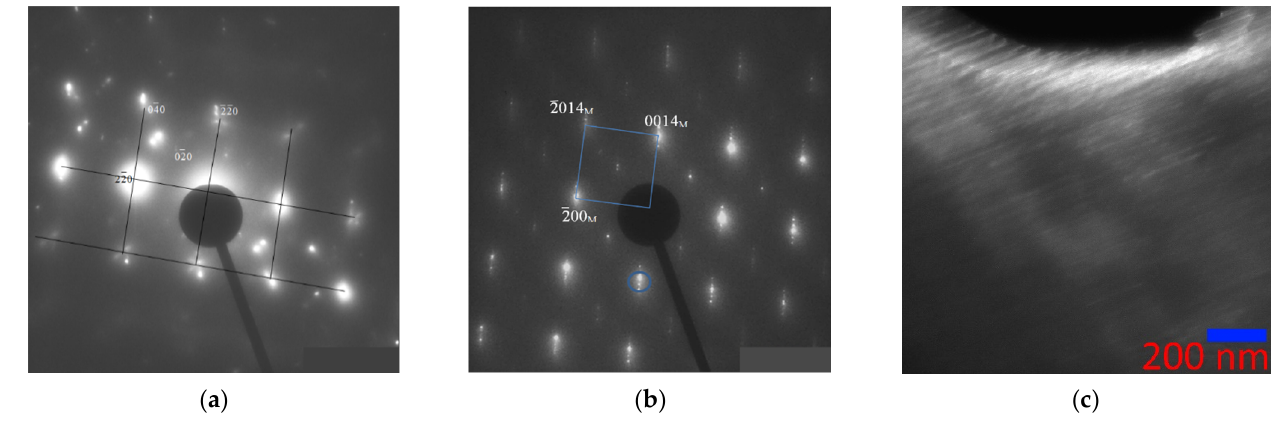
Figure 13. Structure of the Ni 46 Mn 41 In 13 alloy at 208 K: ( a )—electron diffraction pattern of the austenite structure, zone axis [001] L21 ; ( b )—electron diffraction pattern of the martensite structure, zone axis [010] 14M ; ( c )—fine structure of martensite, dark-field image in the (0014)M reflection (circled).